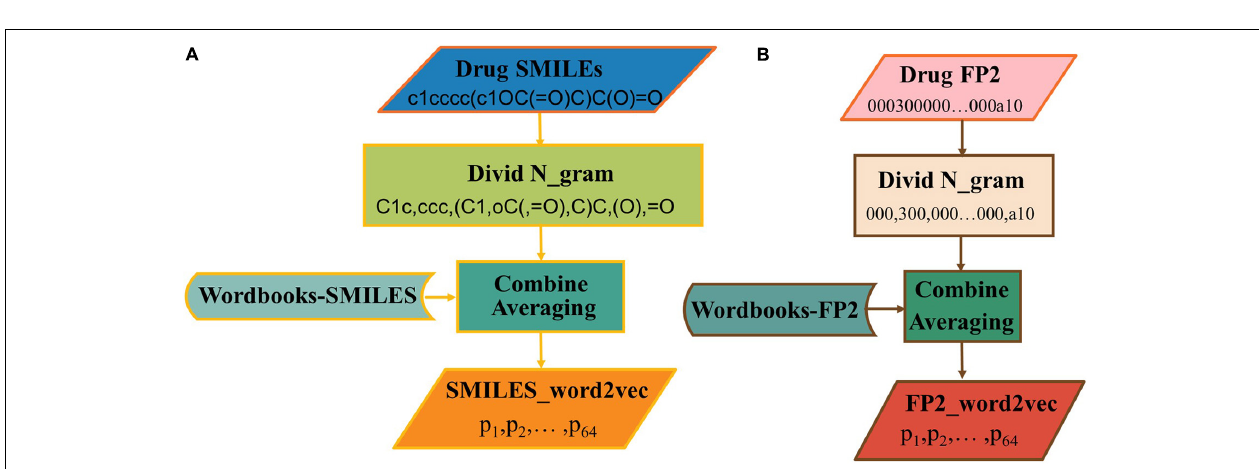
FIGURE 4 | The processes of generating (A) SMILES_word2vec and (B) FP2_word2vec.